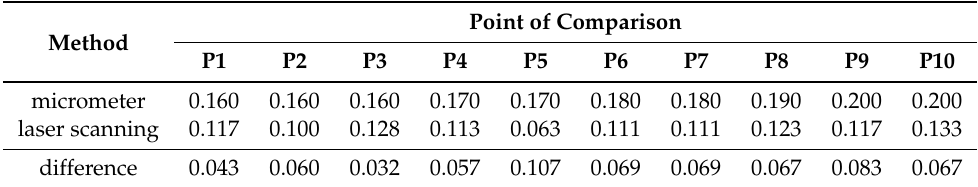
Figure 6. Leaf thickness of a wheat leaf. The meshed point cloud is colorized with the thickness values. The histogram describes the amount of points with a thickness value indicated by the colorbar. Table 3. Comparison of the invasive measured leaf thickness and the laser scanning result for the wheat leaf shown in Figure 6. Units: